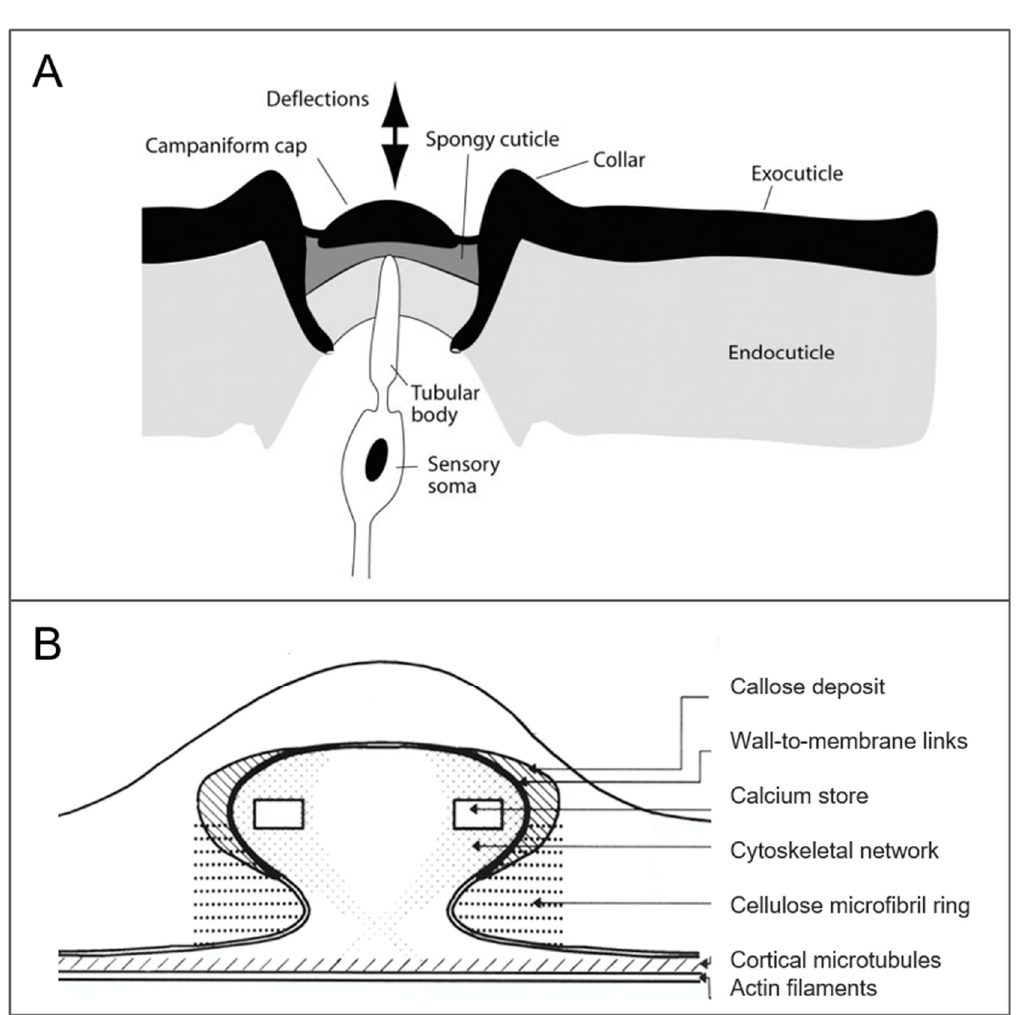
Figure 8. Examples of specialized mechanical sensory organs with a dome shape. ( A ) A diagram of the cross-section of a campaniform sensillum (adapted from [1] by permission of Oxford University Press). ( B ) Tactile blep architecture (reprinted by permission from Springer, [30]).